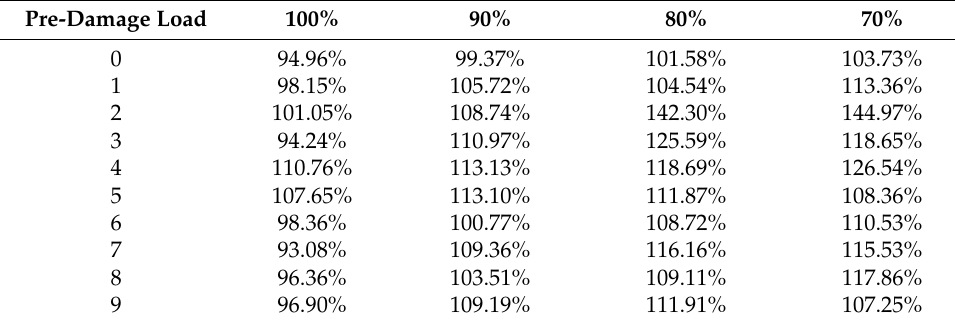
Table 8. Recovery rate of compressive strength after 28 d of